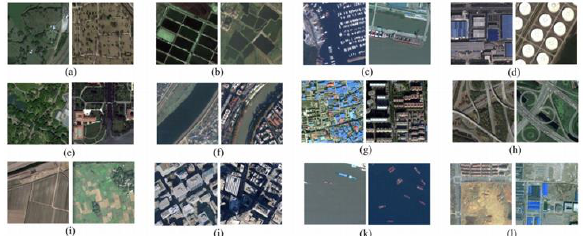
Figure. 4. Google dataset of SIRI-WHU. (a)–(l): meadow, pond, harbor, industrial, park, river, residential, overpass, agriculture, water, commercial, and idle land. The classification performance of different strategies based on